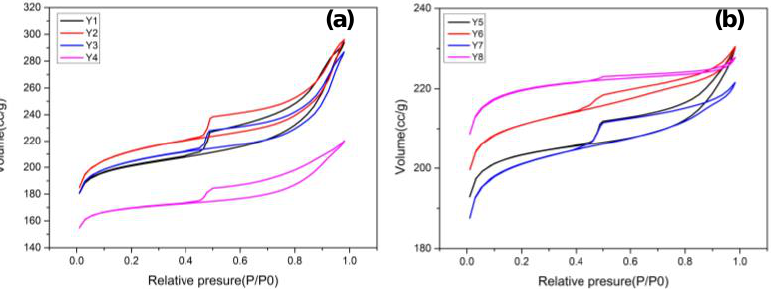
Figure 3. The isotherms of nitrogen physisorption of zeolites ( a ) Y1 – Y4 and ( b )Y5 – Y8.